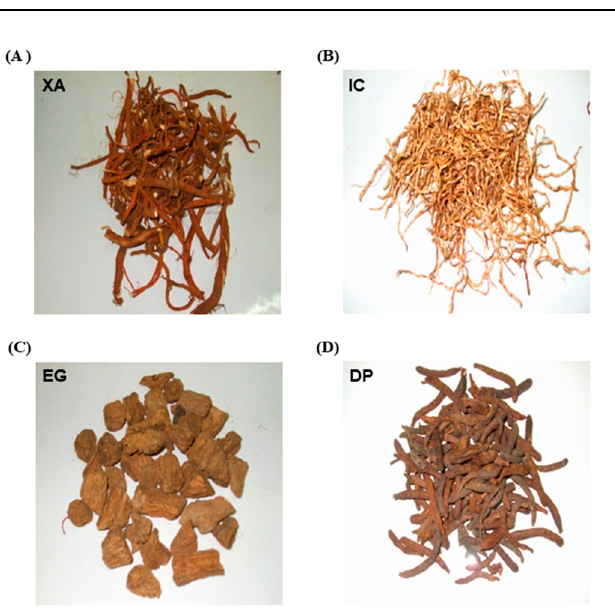
Figure 11. Morphological characteristics of the studied plants: ( A ) XA, ( B ) IC, ( C ) EG and ( D )